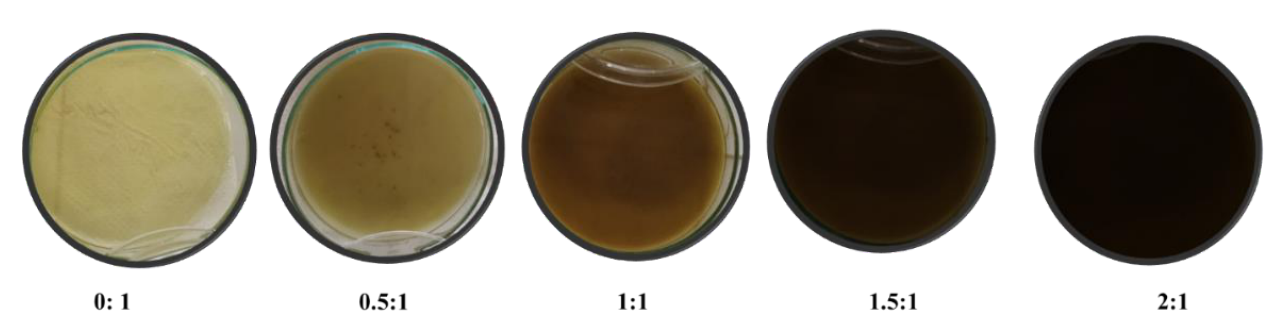
life was increased. Compared to the U/G film, which did not obtain wood ash and showed poor characteristics.